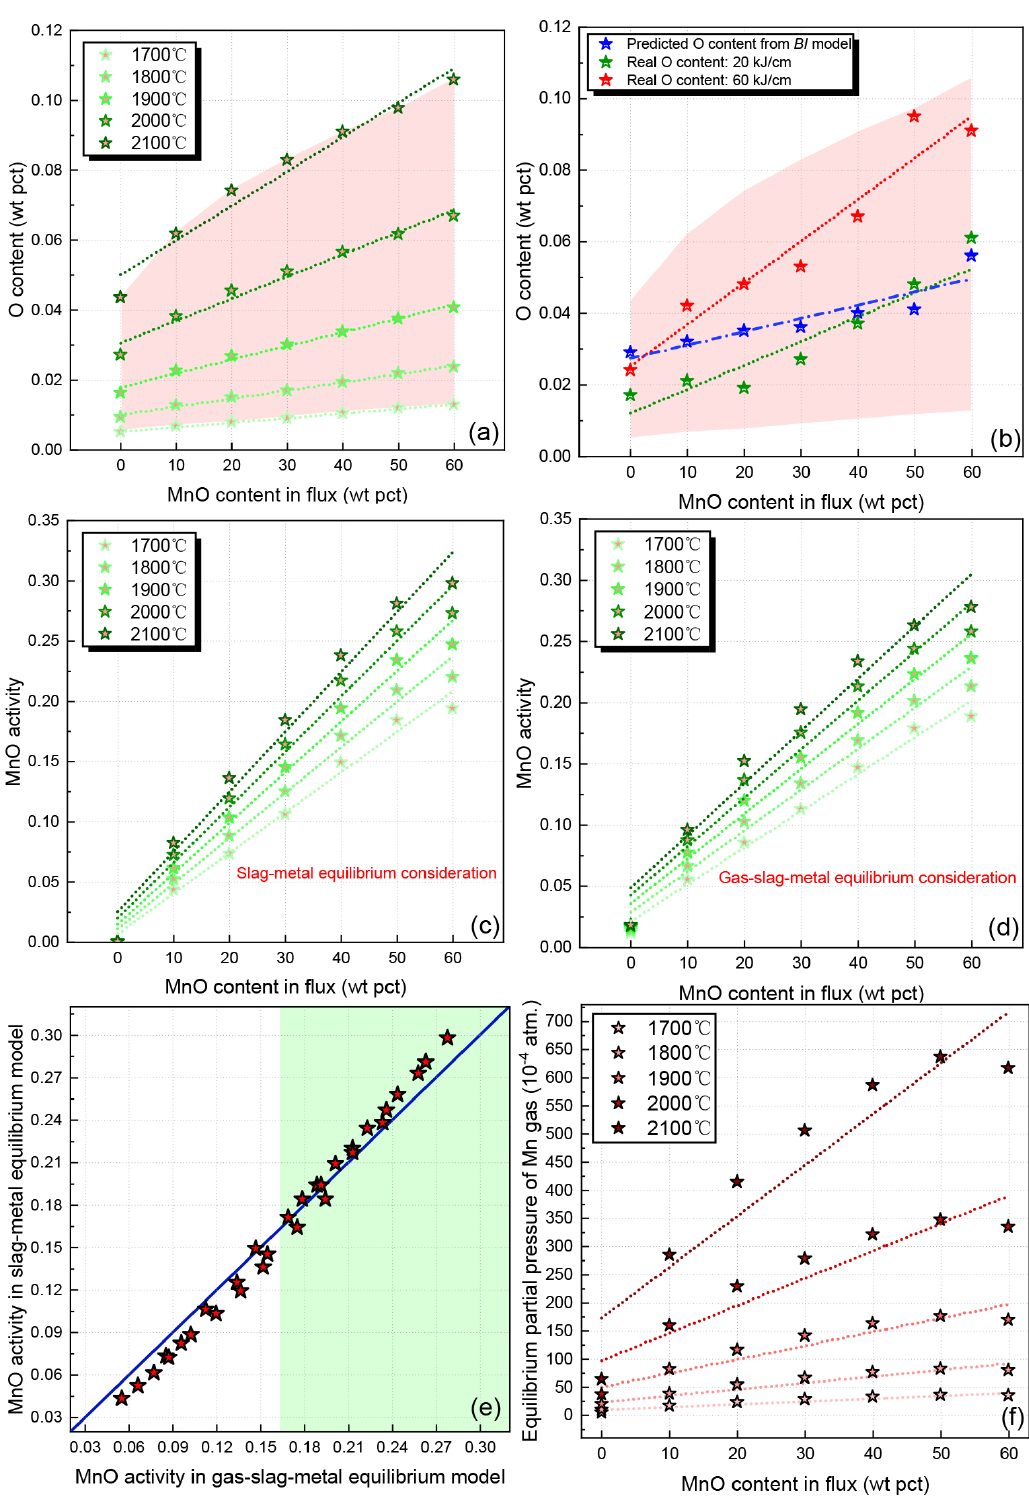
Figure 4. Essential thermodynamic data pertinent to the transfer behavior of Mn: ( a ) predicted O content subject to various EET from gas-slag-metal equilibrium model, ( b ) Real O content of the WM and that predicted from slag-metal equilibrium model (the BI model), ( c ) MnO activity in slag-metal and slag-metal equilibrium model, ( d ) MnO activity in gas-slag-metal and slag-metal equilibrium model, ( e ) deviants between simulated MnO activities in flux and slag, ( f ) Level of equilibrium partial pressure of